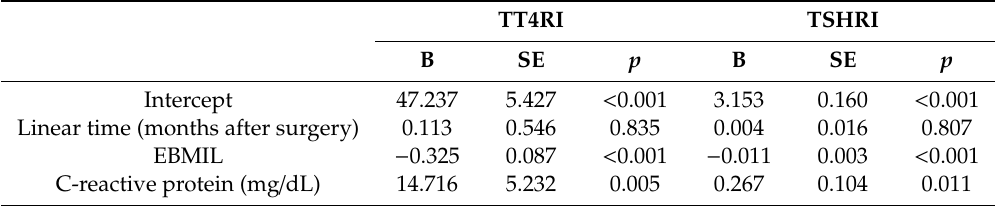
Table 4. Generalized estimating equation model examining change of Thyrotroph T4 resistance index (TT4RI) and TSH resistance index (TSHRI) values after bariatric surgery, adjusting for excessive BMI loss in percentage (EBMIL) and C-reactive protein. TT4RI TSHRI B SE p B SE p Intercept 47.237 5.427 < 0.001 3.153 0.160 < 0.001 Linear time (months after surgery) 0.113 0.546 0.835 0.004 0.016 0.807 EBMIL − 0.325 0.087 < 0.001 <